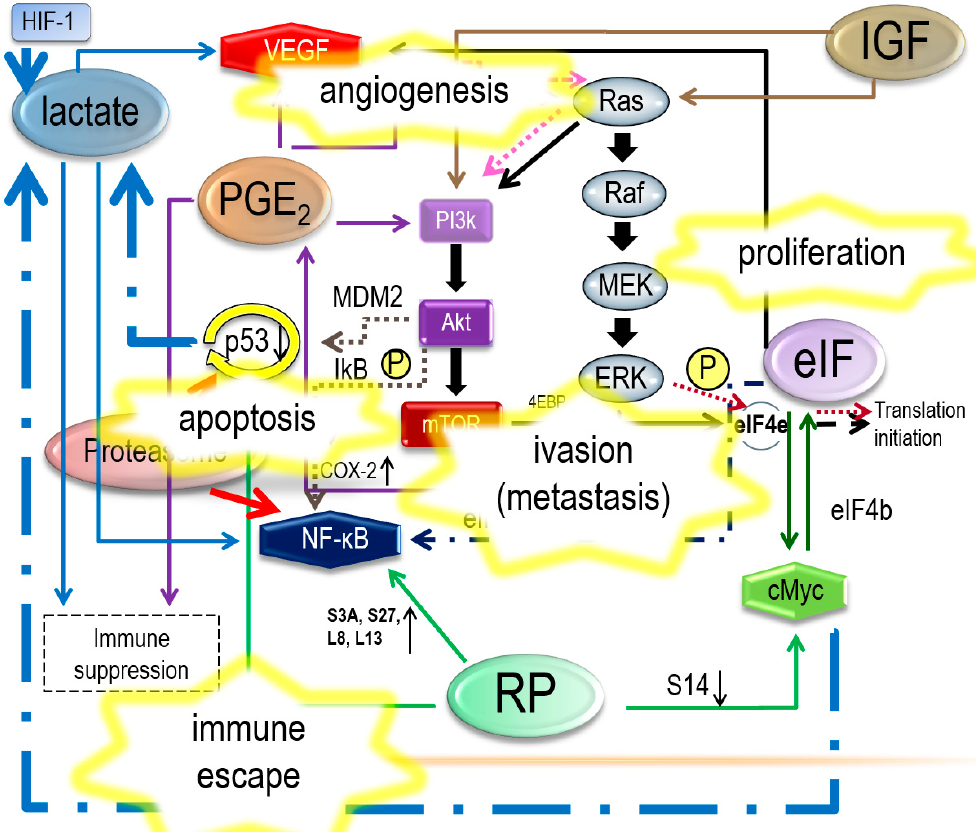
Figure 3. Some events associated with carcinogenesis: angiogenesis, cell proliferation, decrease of apoptosis, and immune escape ; these appear to match some of the conditions necessary for carcinogenesis.